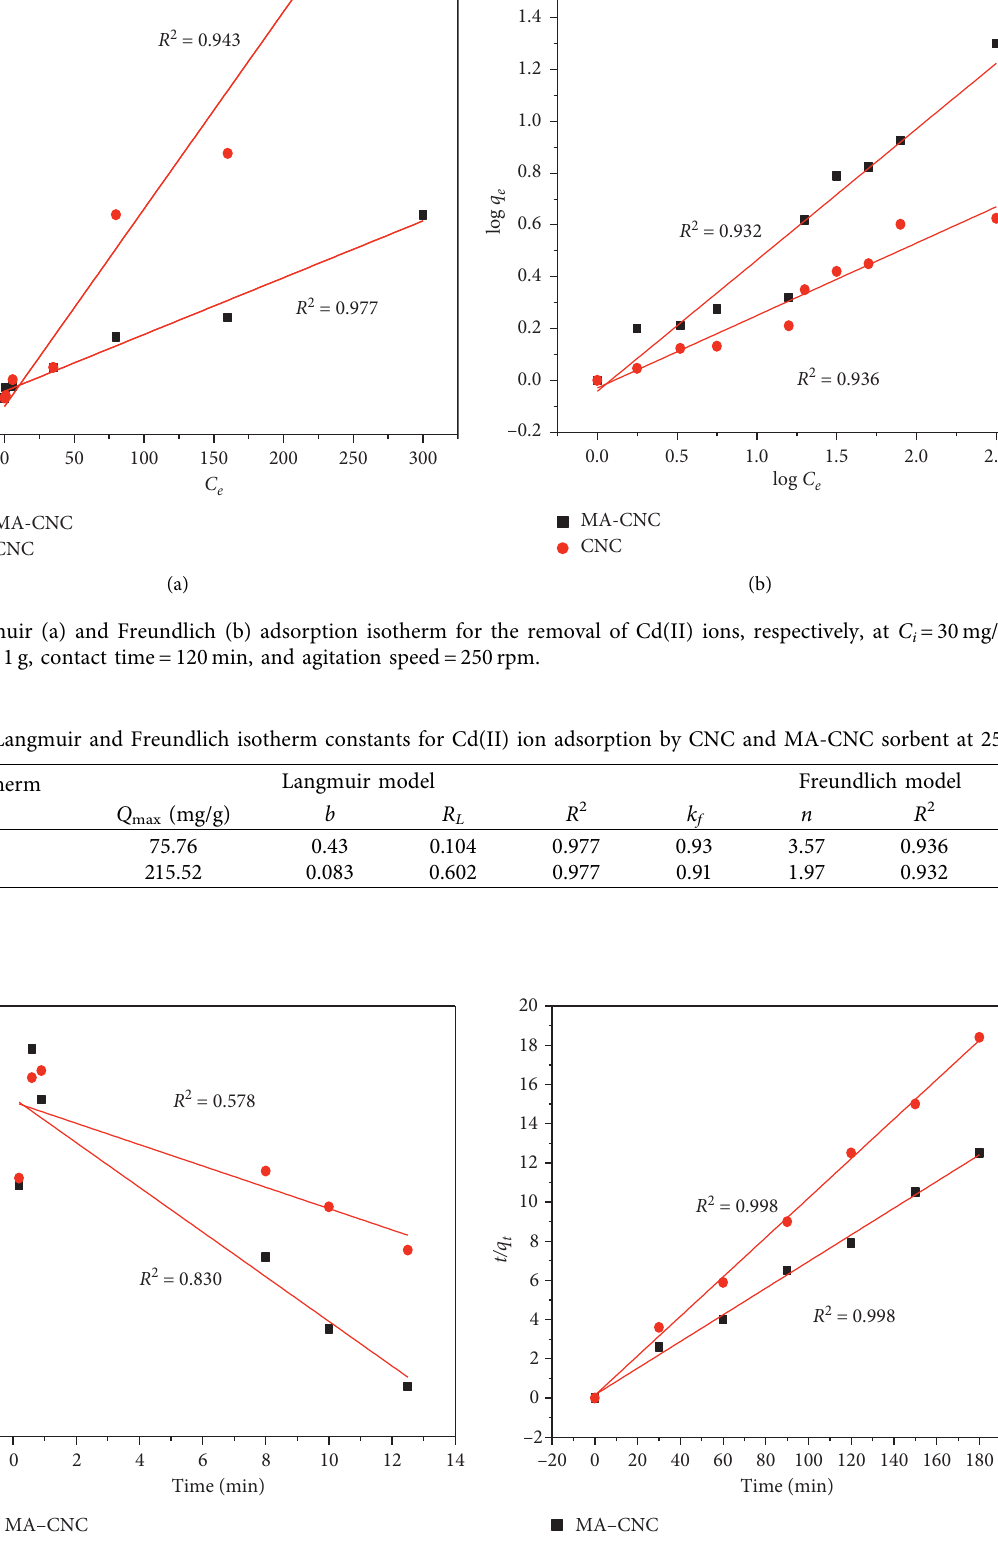
� 30mg/L, pH � 6, adsorbent dose � 1g, contact time � 120min, and agitation 0